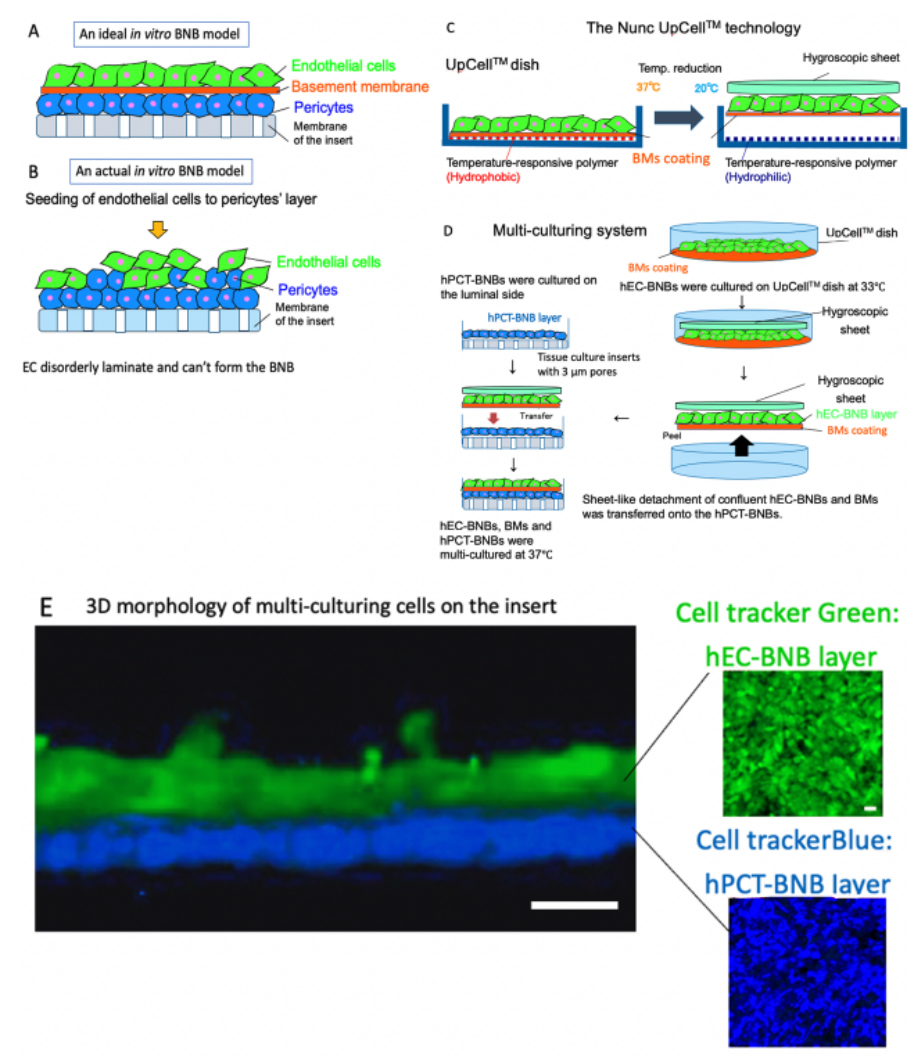
Figure 3. Construction of a new in vitro BNB model. ( A ) An ideal in vitro human BNB model. The Figure 3 endothelial cells form the monolayer. The BNB components (pericytes and basement membrane) are in direct contact with the monolayer of endothelial cells on the tissue culture insert. ( B ) An actual in vitro human BNB model. If endothelial cells are forcibly multi-cultured on the layer of pericytes, they disorderly laminate and cannot form the BNB due to the difference in growth speed of each cell line. ( C ) The Nunc UpCell TM technology. Temperature-responsive polymer is immobilized on the surface of the UpCell TM dish. The polymer-grafted surface shows reversible hydrophobic and hydrophilic properties across the threshold temperature of 20 ◦ C. The cell-sheet is detached from the dish without harmful enzymes (e.g., trypsin or dispase) and attached to the hygroscopic sheet to transfer. ( D ) Multi-culturing systems. hPCT-BNBs were cultured on the luminal side of the cell culture insert membrane with 3 µ m pores. After flipping the cultured insert, hPCT-BNBs were cultured on the luminal side. hEC-BNBs were cultured in an UpCell dish. After incubation at 20 ◦ C, the sheet of confluent hECs was detached and transferred onto the hPCT-BNBs. ( E ) Confocal 3D analysis with live staining of hEC-BNBs and hPCT-BNBs. Multi-cultured insert constituted the two-layer structures, which consisted of hEC-BNBs and hPCT-BNBs. The layer of hPCT-BNBs was close to the hEC-BNBs. Bar = 5 µ